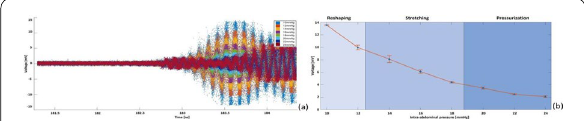
Fig. 2. Obtained results from this investigation (a) Reflection response of the abdominal model at different IAP values between 10 and 24 mmHg. (b) The reflection response of the abdominal model at a specific moment in time (183.5 ns) Conclusion. TRM is a non-invasive, contact-free, continuous monitor- ing technique that can potentially be used in clinical monitoring. How- ever, as TRM can only track relative IAP changes, the TRM calibration [8] in combination with IAP calibration before the start of a measure- ment cycle is an issue that needs to be solved in the future. Applica- tion of machine learning techniques is one of the options to solve this